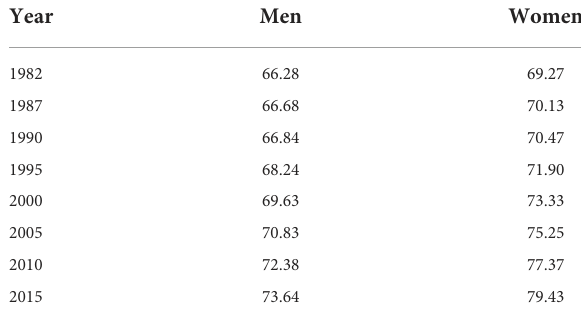
TABLE 1 Life expectancy in China,